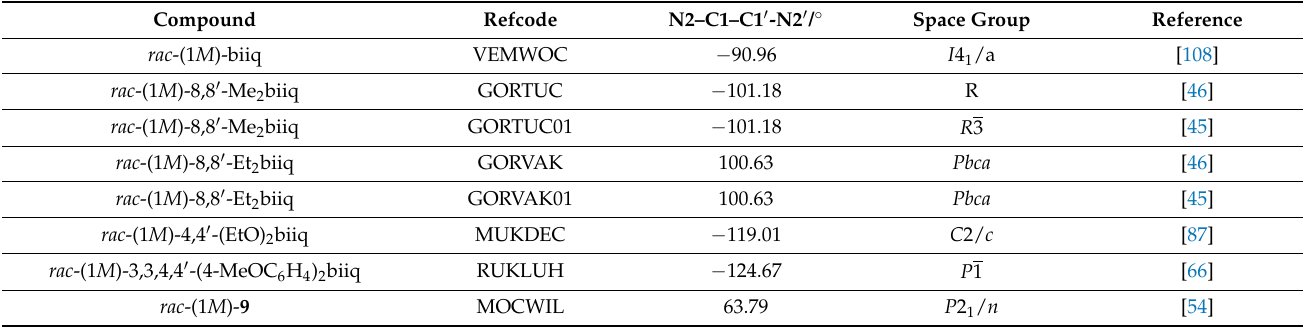
Table 1. Structurally characterized 1,1 (cid:48) -biisoquinolines.